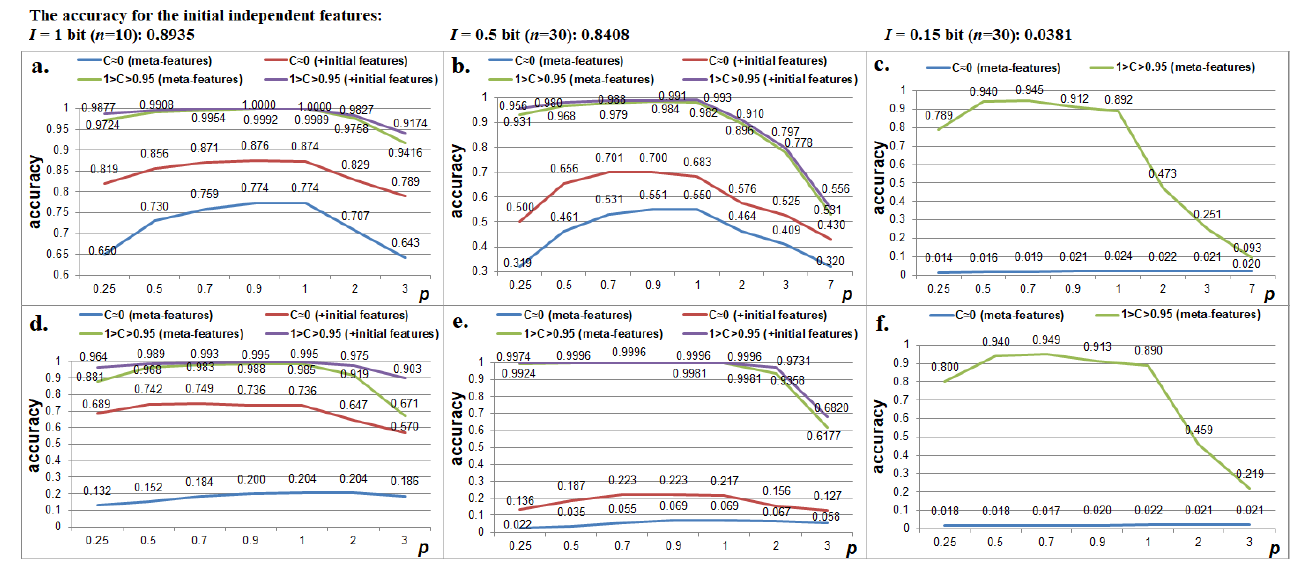
Figure 7. Changing the accuracy of the identification of images based on the “ naive ” Bayes classifier with various average informativeness of the initial features, when applying the mapping in (12): ( a ) I ≈1 bits, n = 10 and n ’ = 45; ( b ) I ≈0.5 bits, n = 30 and n ’ = 435; ( c ) I ≈0.15 bits, n = 30 and n ’ = 435, and when applying the mapping in (11): ( d ) I ≈1 bits, n = 10 and n ’ = 45; ( e ) I ≈0.5 bits, n = 30 and n ’ = 435; ( f ) I ≈0.15 bits, n = 30 and n ’ = 435.